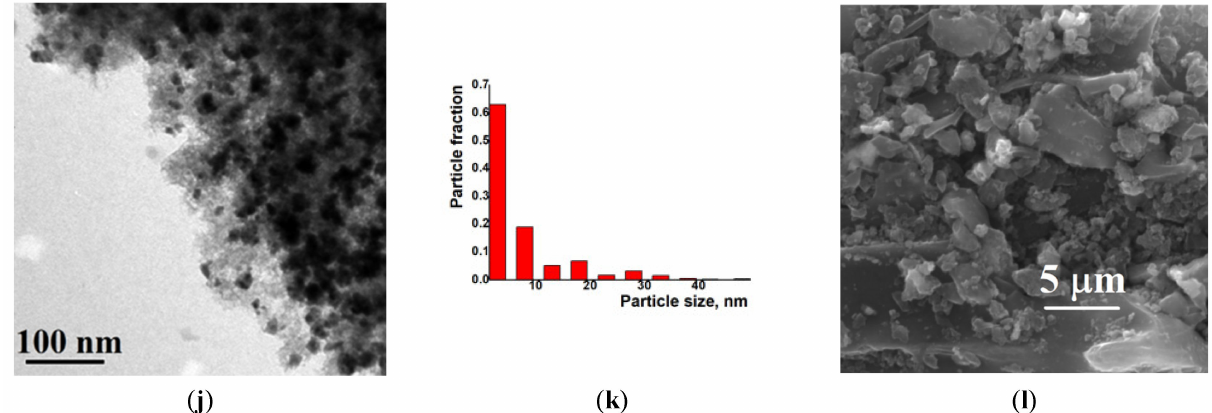
Figure 4. TEM (left column), particle distribution by size according to the TEM data (middle column) and SEM (right column) images of the composites Ni/C-1 ( a – c ), Ni/C-3 ( d – f ), Ni/C-5 ( g – i ), and Ni/C-10 ( j – l ).